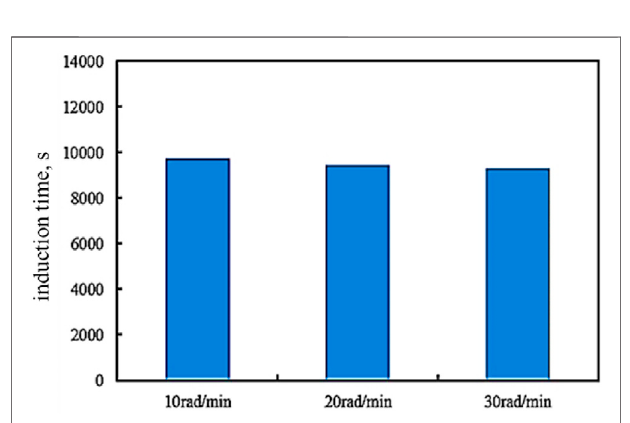
FIGURE 14 | the activity of water in water-compound inhibitor binary